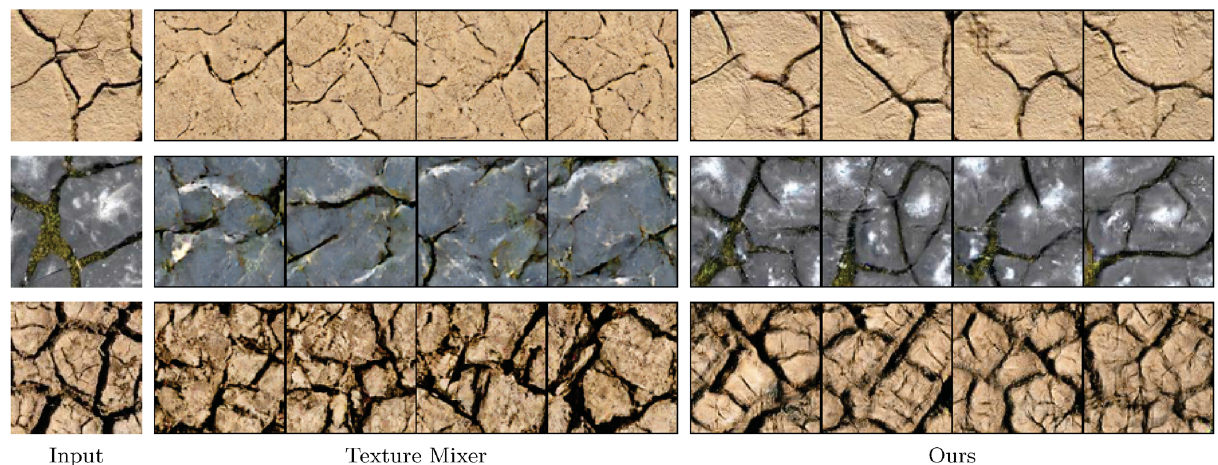
Fig. 8 Fidelity and diversity comparison. Given an input crop (left), we demonstrate samples synthesized using Texture Mixer [29] (center) and our technique (right). Note that unlike Texture Mixer, we do not encode the input crop directly—we generate samples conditioned on its co-occurrence matrix. While both methods generate diverse results, our method seems to better respect the properties of the input texture crop.